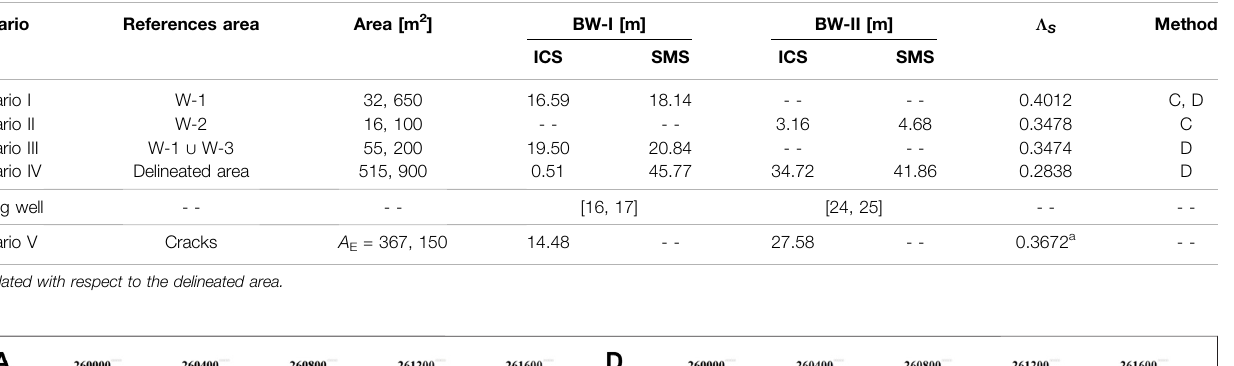
Frontiers in Earth Science |